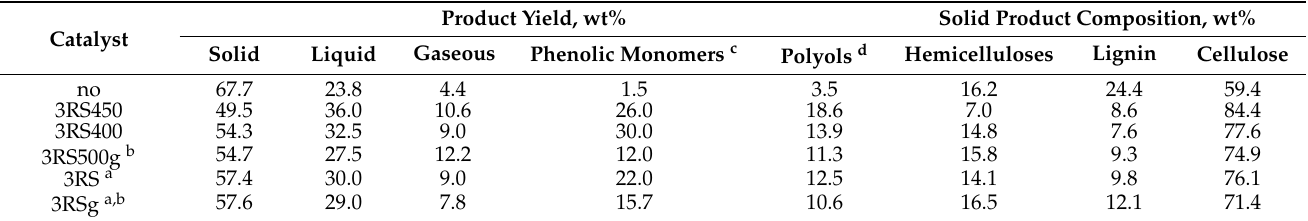
Table 2. The results of RCF of spruce wood at 225 °C for 3 h over different Ru catalysts.